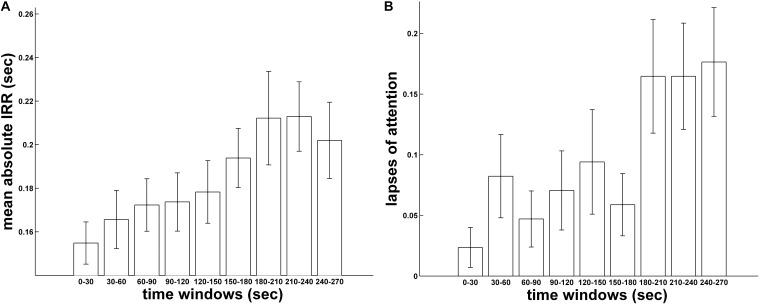
Mean absolute IRRs (A) and mean distribution of attentional lapses (B) as a function of time divided into equal size time windows of 30 s.